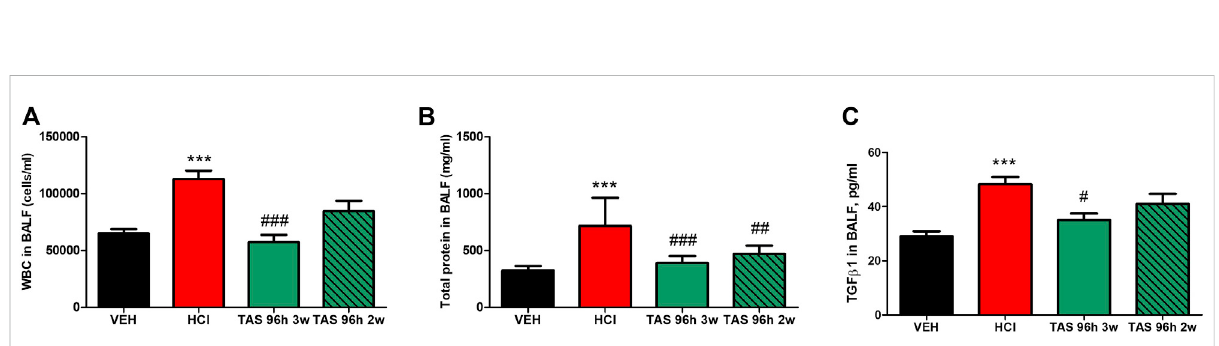
Oral treatment with TAS-116 — starting either 24 or 96 h after HCl-ameliorates HCl-induced lung dysfunction. Both 24 h and 96 h treatment groupshadasigni fi cantimpactonpreventingadownwardshiftofpressurevolume(PV)loops afterHClinstillation (A) .Respiratorysystemresistance (Rrs), elastance (Ers), and damping (G) increased, compared to control mice in all groups instilled with HCl (B – D) . This increase was signi fi cantly dampenedinTAS-116treatedmice.Means±SEM; n =6micepergroup;****: p < 0.0001fromVEH; # : p < 0.05, ## : p < 0.01, ### : p < 0.001from HCl, with one- or two-way ANOVA and Tukey ’ s post-hoc test.